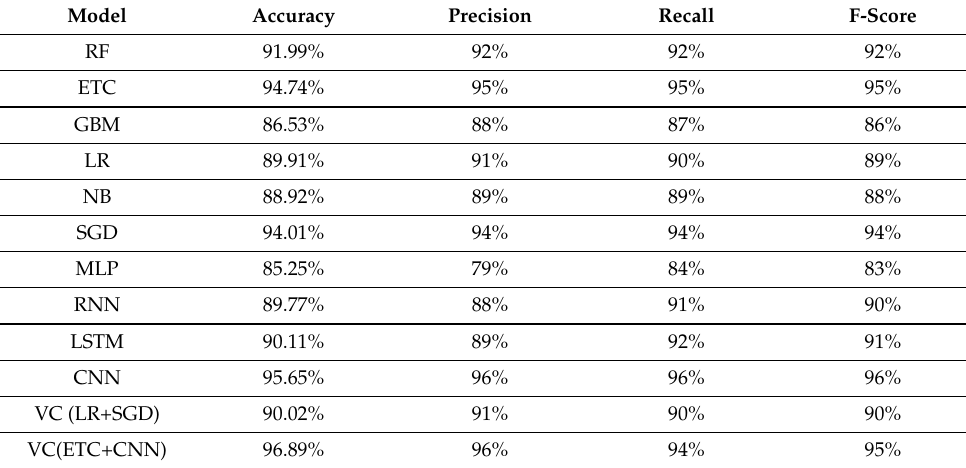
Table 4. Comparison of classifiers using TF-IDF.